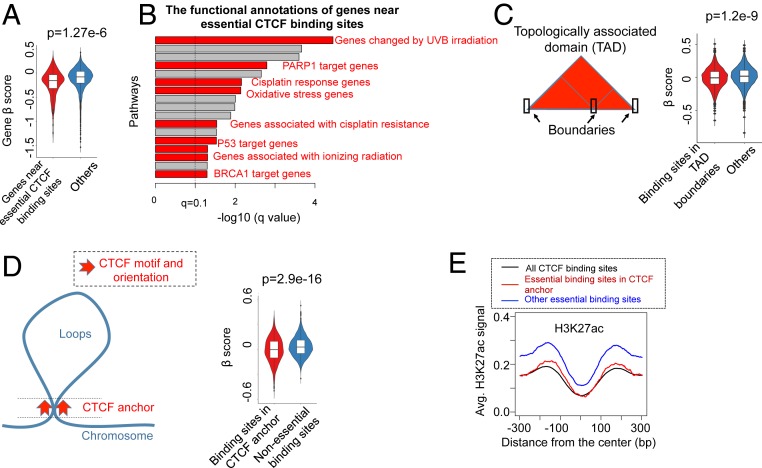
Essential CTCF binding sites display distinct types of CTCF binding. (A) The β-score distribution of genes near essential CTCF binding sites, compared with all genes in the genome. The P value is calculated using the Mann–Whitney U test. (B) The functional analysis of genes near essential CTCF binding sites using the GREAT prediction tool (46). Enriched terms related to DNA damage and stress response are highlighted in red. (C) The β-score distribution of binding sites in the boundaries of TADs. (D) The β-score distribution of binding sites in CTCF anchors, or regions that contact chromosome loops and with CTCF motifs that are head-to-head oriented. The anchor annotation is extracted from Hi-C experiments (31). (E) The H3K27ac signal strength distribution of essential binding sites in CTCF anchors, other essential binding sites, and all CTCF binding sites.